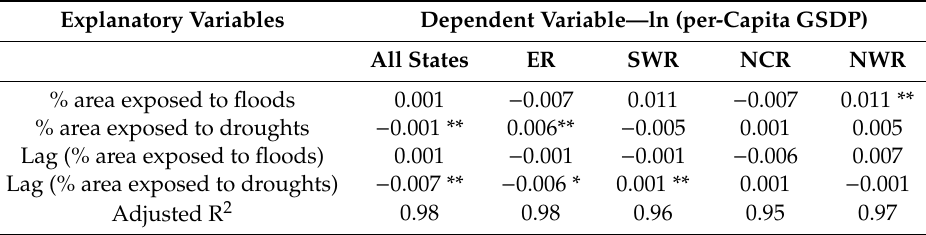
Table 7. Regressions on flood and drought-a ff ected areas with total per-capita GSDP.